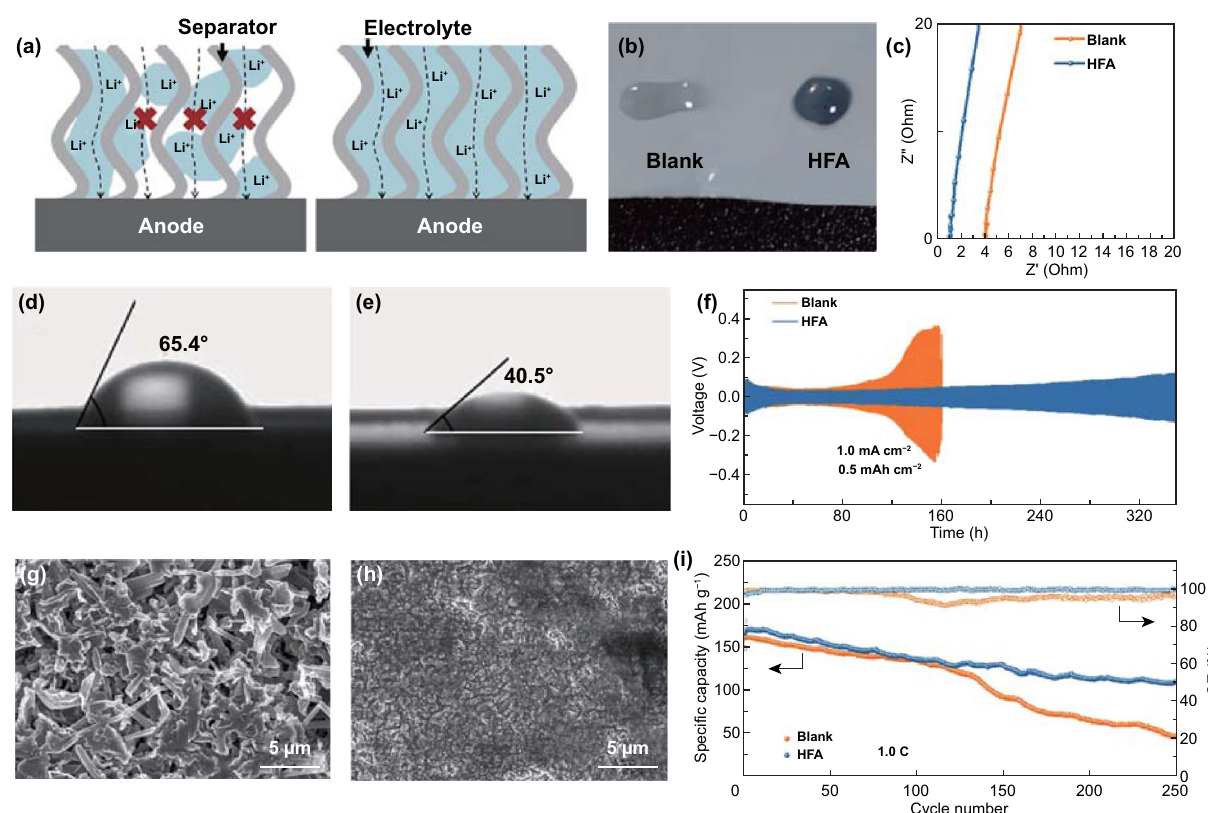
Fig. 1 a Schematic illustration of the impacts of separator wettability toward electrolyte on Li + transportation. b The photograph of different electrolytes dropped on the separator. c EIS result of SS||SS symmetric cells in different electrolytes. d The contact angles on separator for blank electrolyte. e The contact angles on separator for 1.0 wt% HFA-contained electrolyte. f The cycle performance of Li||Li symmetric cells in dif- ferent electrolytes. g SEM image of Li anode after 50 cycles in blank electrolyte. h SEM images of Li anode after 50 cycles in 1.0 wt% HFA- contained electrolyte. i Cycling performance of Li||NCM622 cells in different